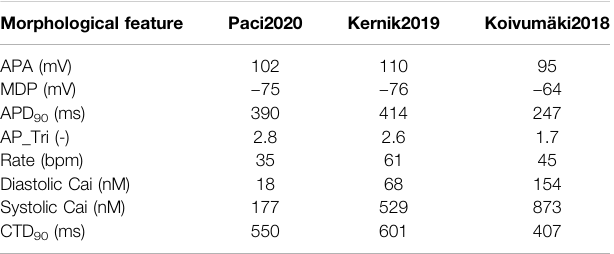
TABLE 2 | Morphological features from spontaneous action potentials (APs) and Ca 2+ transients (CaTs). Morphological